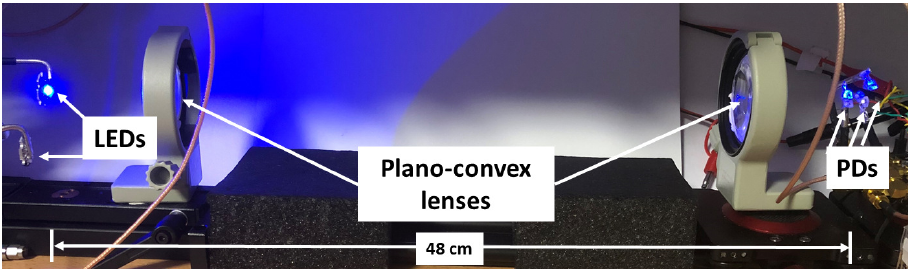
Figure 5. Photograph of optical component